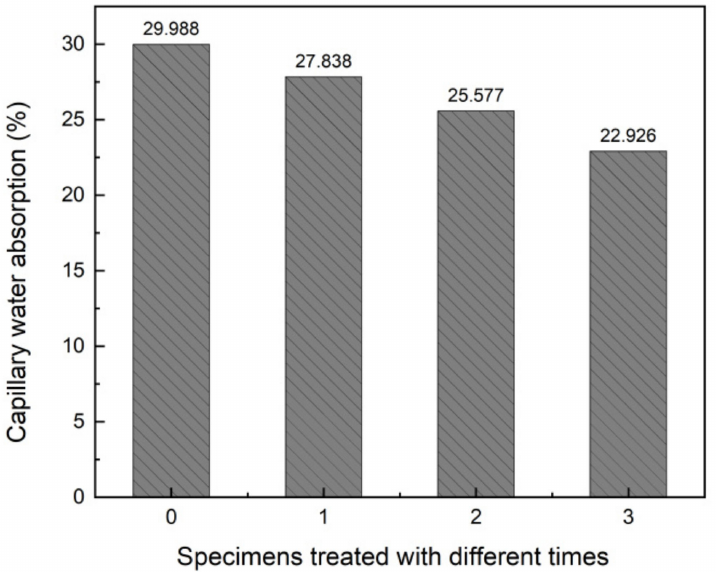
Figure 13. Capillary water absorption of the specimens before and after treatment.